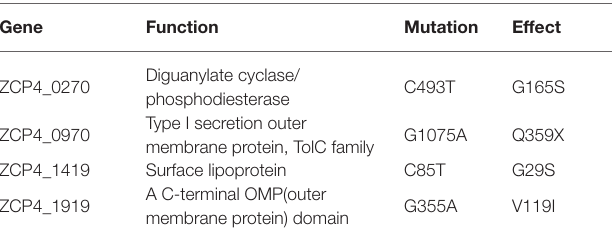
TABLE 1 | Mutations identified in the F211